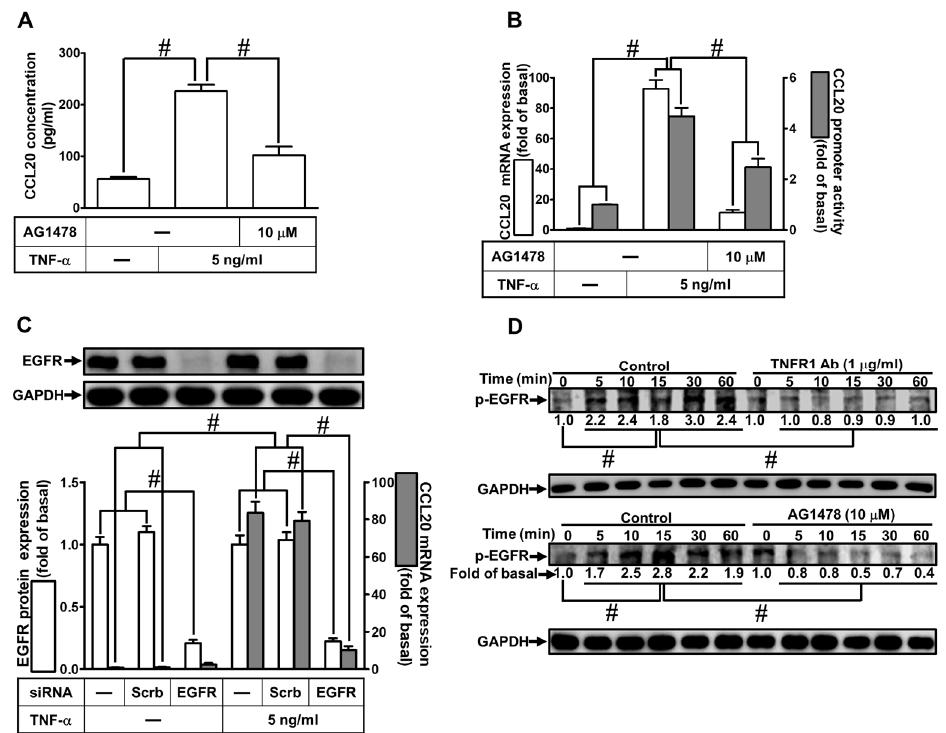
Figure 3. Involvement of EGFR in TNF- α -induced CCL20 expression. ( A ) Cells were pretreated with 10 μ M AG1478 for 1 h and then incubated with 5 ng/mL TNF- α for 12 h. The conditioned media were utilized to determine the CCL20 level via an ELISA kit. ( B ) Cells were pretreated with 10 μ M AG1478 for 1 h and then incubated with 5 ng/mL TNF- α for the indicated time. The mRNA levels and promoter activity of CCL20 were determined by real-time PCR (2 h) and promoter assay (4 h), respectively. ( C ) Cells were transfected with scrambled or EGFR siRNA and then incubated with TNF- α for 2 h. The mRNA levels of CCL20 were determined by real-time PCR. The protein levels of EGFR were determined by Western blot with GAPDH as a loading control. ( D ) Cells were pretreated without or with 1 μ g/mL TNFR1 Ab or 10 μ M AG1478 for 1 h and then treated with TNF- α for the indicated time (0, 5, 10, 15, 30, and 60 min). The phosphorylation of EGFR was determined by Western blot with GAPDH as a loading control. Data are expressed as mean ± S.E.M. of three independent experiments ( n = 3). # p < 0.05, as compared with the cells exposed to vehicle alone; or significantly different as indicated.